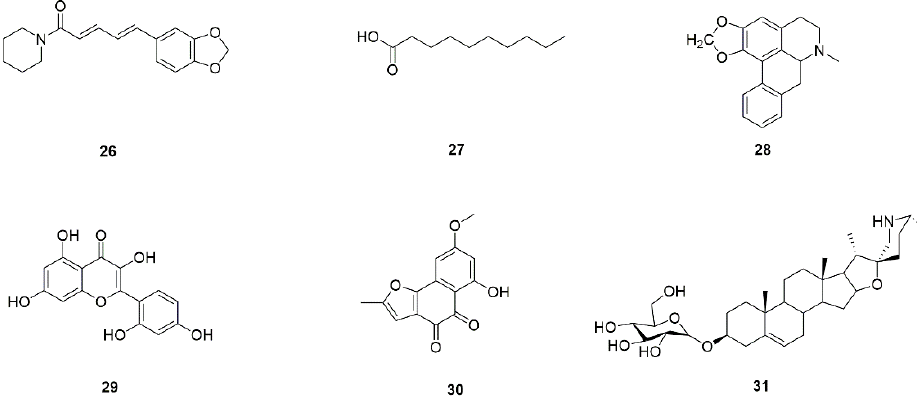
Figure 11. Chemical structures of natural compounds targeting multiple virulence factors.